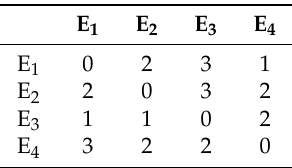
Table 3. The averaged direct-relation matrix for dimensions.